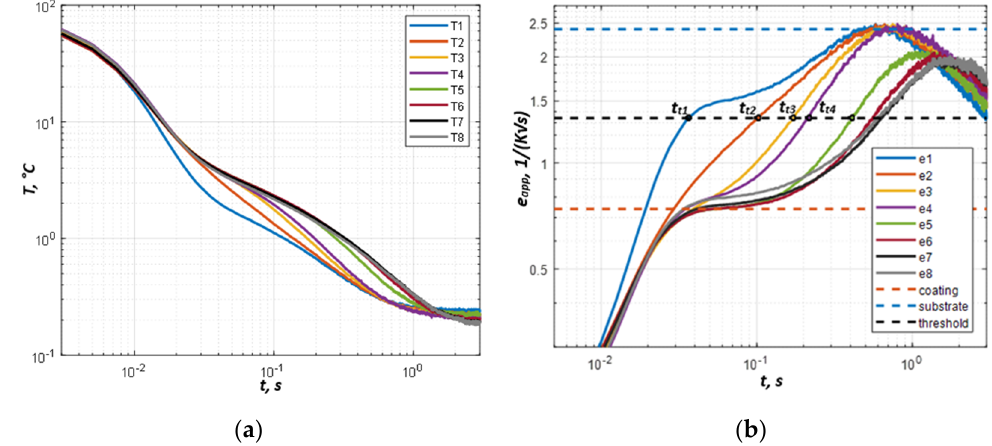
Figure 7. Experimental evolution of temperature ( a ) and apparent e ff usivity ( b ) for steel sample with Fe 13% Cr TWAS coating (Figure